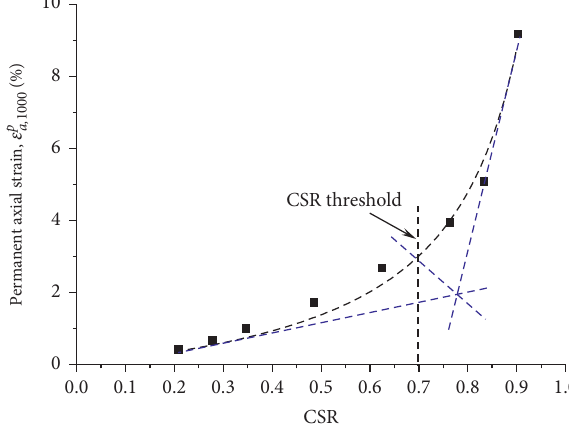
Figure 15: Relationships between ε p